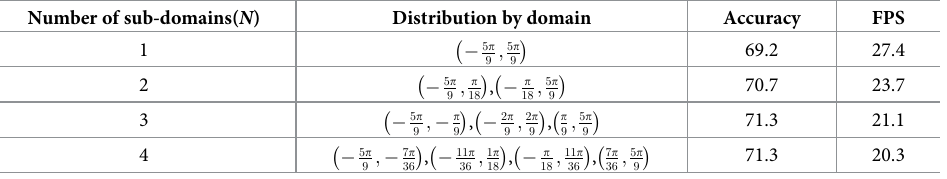
Table 3. Ablation study of the number of sub-domains. Number of sub-domains( N